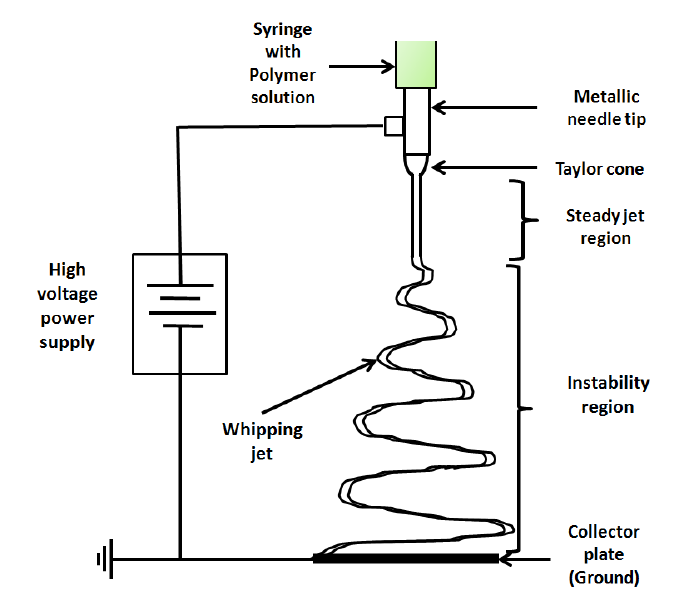
Figure 1. Typical experimental setup for